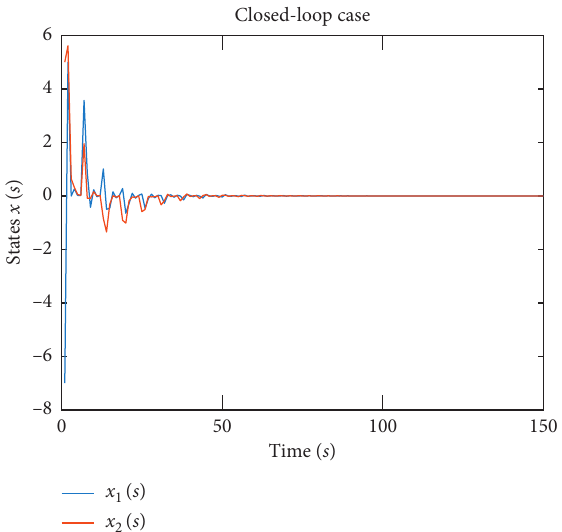
Figure 2: The state trajectories of closed-loop DTNSNSs (5) with time delay and delay-feedback